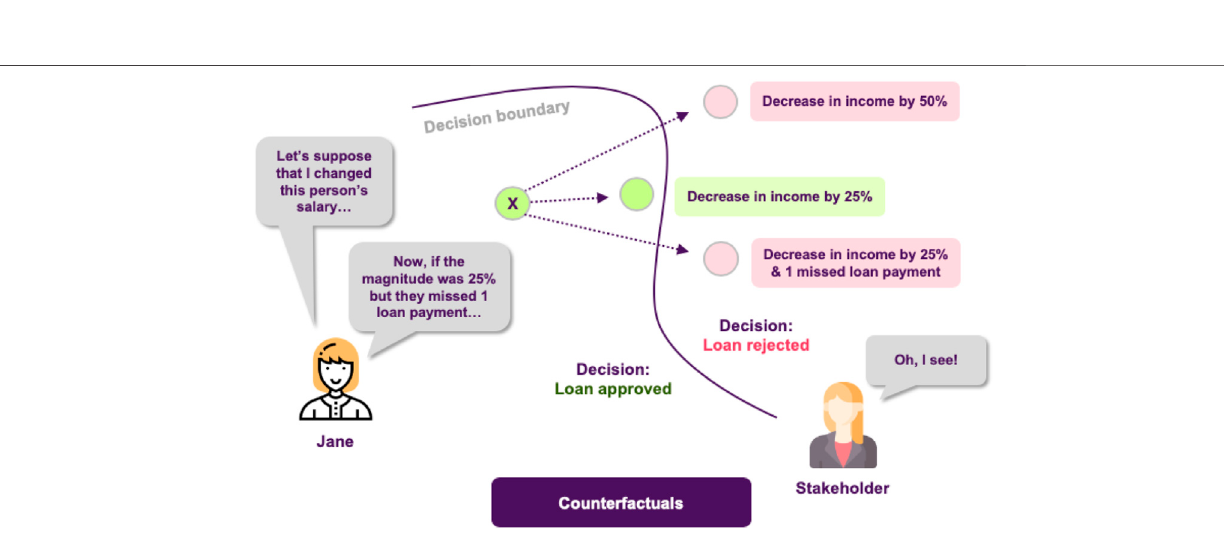
Frontiers in Big Data |